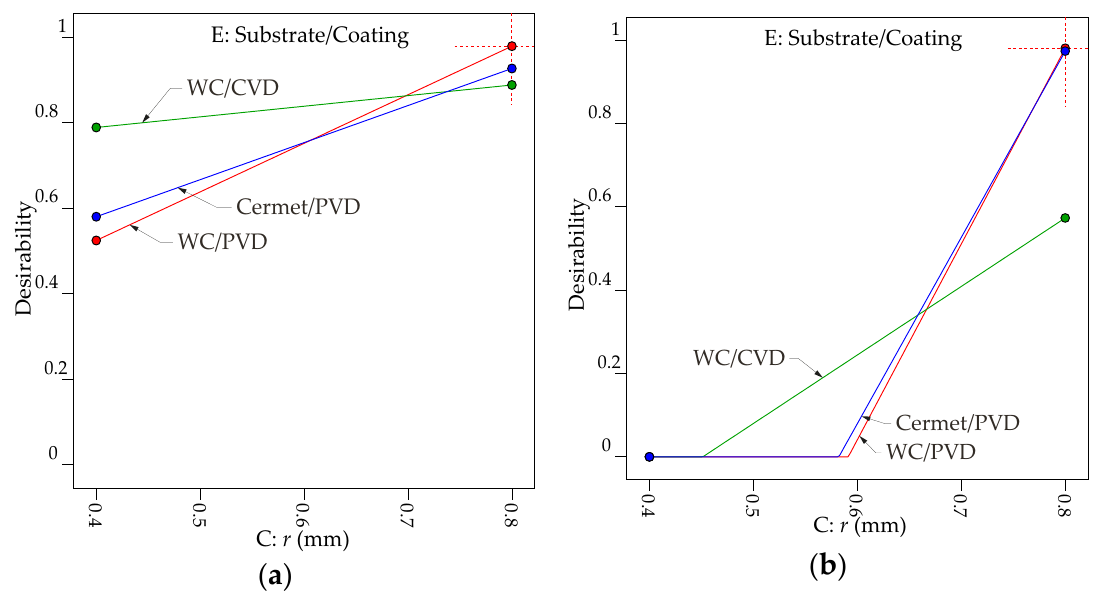
Figure 15. Graphs of optimization results to minimize roughness parameters with the maximum removal rate: interaction effects between Substrate/Coating* r for ( a ) Ra , ( b ) Rz .